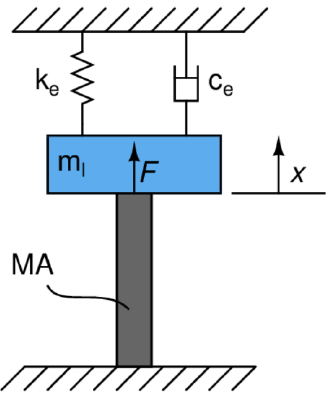
Figure 12. Equivalent single DOF model of